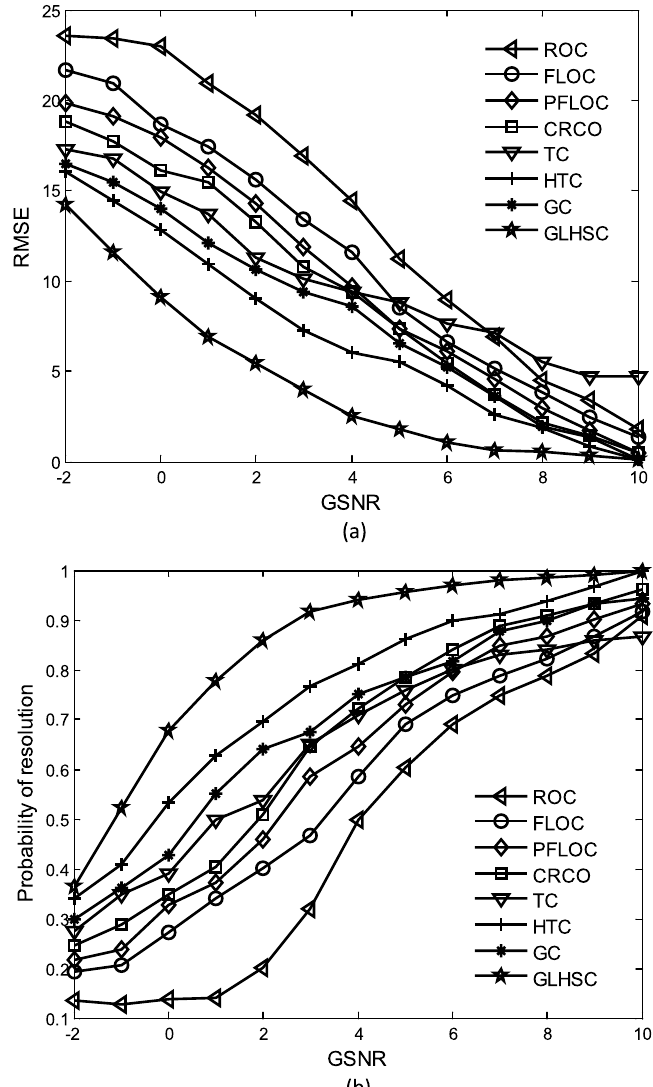
Fig. 6 Performance versus GSNR ( α = 1.2 ). a RMSE, b Probability of